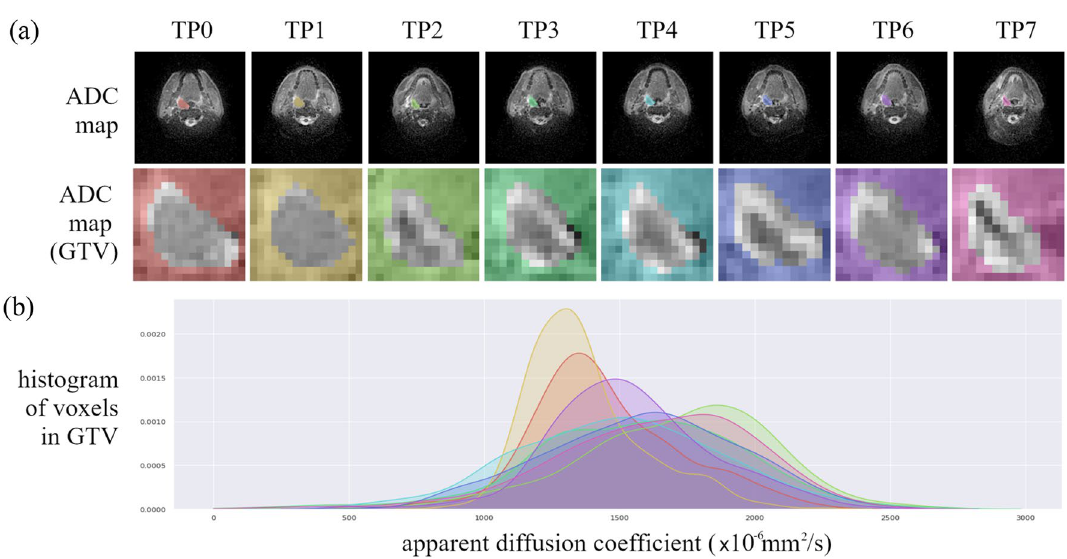
Figure 5. Impact of the reproducibility threshold on the number of ( a ) IBEX and ( b ) MaZda radiomics features used for clustering and the resulting clustering similarity. The number and composition of feature types is shown with the coloured area chart and shows a decrease in the number of features as the reproducibility threshold increases. The (black line) clustering similarity is relatively unchanged for a threshold up till 0.85 after which there is a general increase in accuracy for IBEX features. Two reliability thresholds are highlighted where (red dashed line) generates patient groups in IBEX with one patient classified differently and identical patient groups in MaZda and the (red dotted line) generates identical patient groups in both